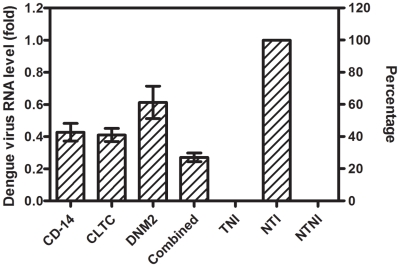
Intracellular dengue virus RNA load.Viral RNA levels were quantified by RT-QPCR and normalized to reference gene (RPL22). Data is expressed as relative fold expression to non-transfected infected monocytes control, which defined as 1.0 fold. Results show (0.57 fold±0.10), (0.59 fold±0.07), (0.39 fold±0.18), and (0.73 fold±0.05) reduction in viral RNA load in CD-14 associated molecule, CLTC, DNM2, and combined silenced monocytes, respectively (One-way ANOVA with Dunnett's post-test, P<0.0001, Error bars are ± SD). (TNI, Transfected Non-Infected; NTI, Non-Transfected Infected; NTNI, Non-Transfected Non-Infected).